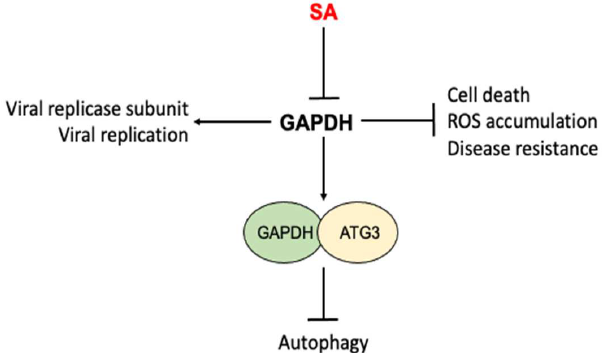
Figure 5. Inhibition of nonmetabolic activities of GAPDH by SA. GAPDHs from both plants and humans participate in a number of nonmetabolic processes including viral replication, cell death, ROS accumulation, disease resistance and autophagy. SA directly binds to GAPDHs and affects the nonmetabolic activities of GAPDH.